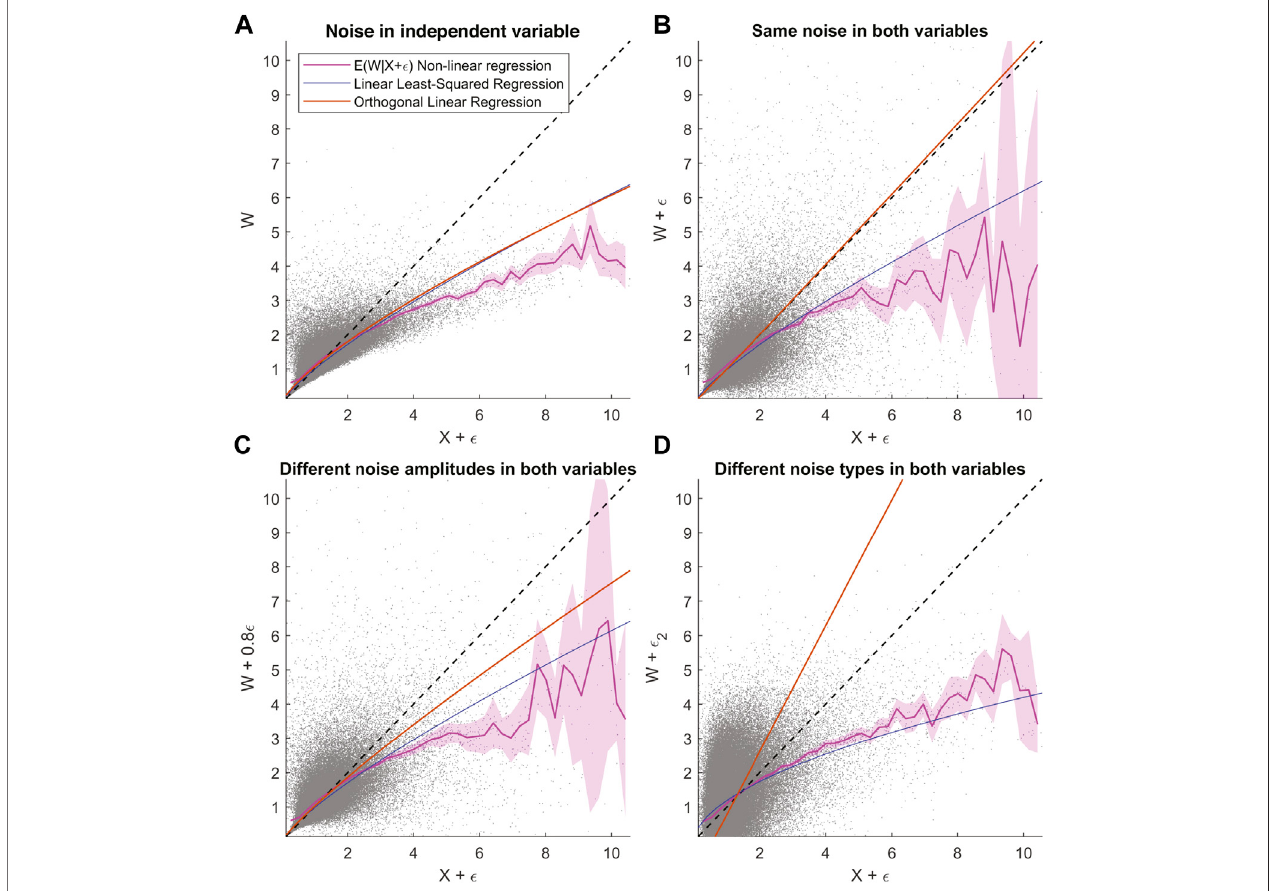
FIGURE5| Comparingtheeffectofregressiontothemeanonnon-linearregression,linearleast-squaresregression,andorthogonalregressionfunction.Similarto Figure 4 , X is log-normally distributed with W = X , and ϵ is Gaussian uncertainty that is correlated with X such that σ ( ϵ ) ∝ X 2 . (A) Shows different regression fi ts on data with uncertainty added only to X . (B) Shows the same with added uncertainty and the same characteristics on both X and W . (C) Shows the same but with slightly less uncertaintyaddedto W comparedto X . (D) ShowsthesameplotwithuncorrelatedGaussianuncertainty ϵ 2 addedto W ,whilecorrelatedGaussianuncertainty ϵ as in B is added to X